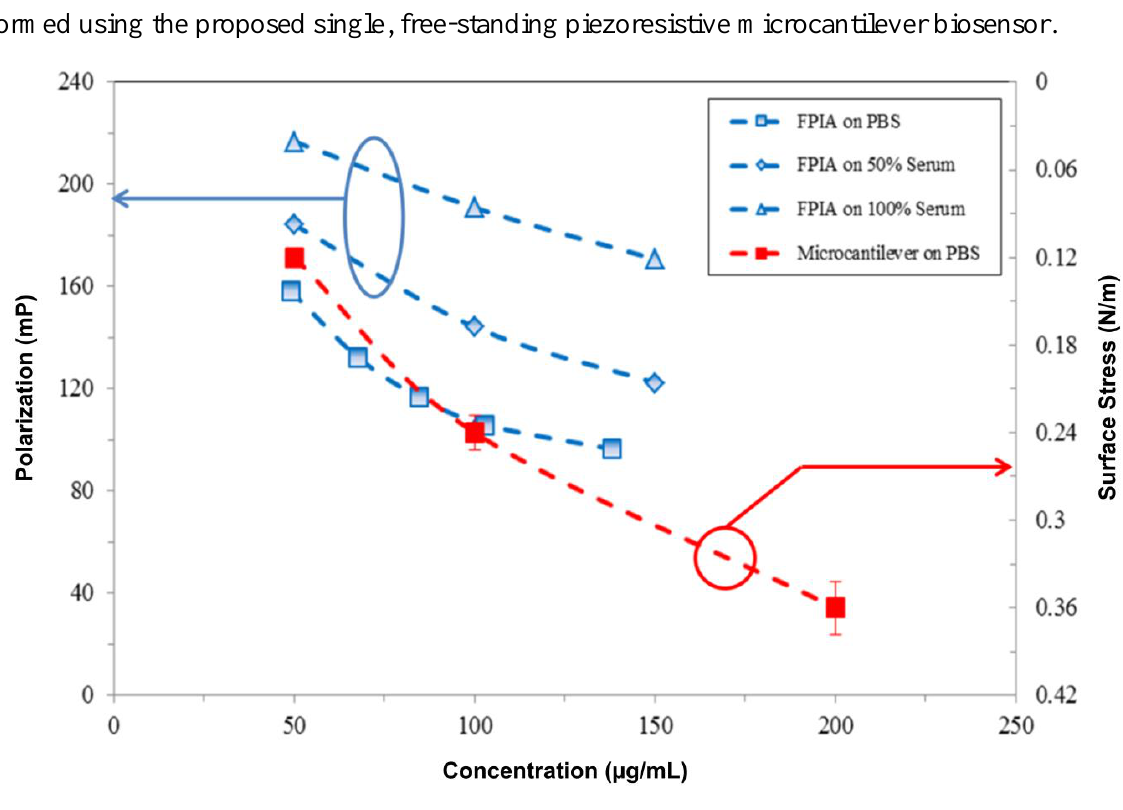
Figure 6. The similar tendency of the response signals obtained by the fluorescence polarization immunoassay (FPIA) and the present microcantilever biosensor in PBS, 50% serum and pure